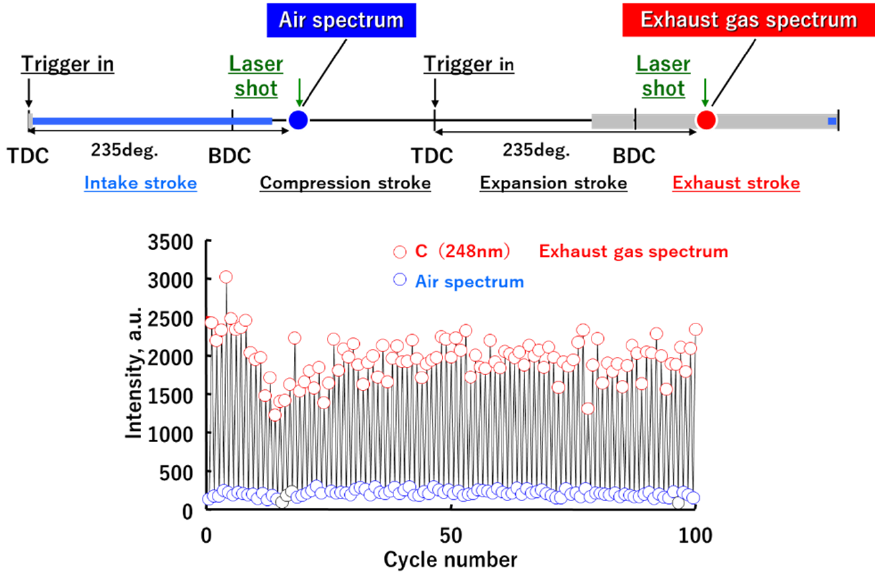
Figure 8. Spectrum intensity at 248 nm for each laser shot. The C atomic spectra is only observed in the exhaust gas.